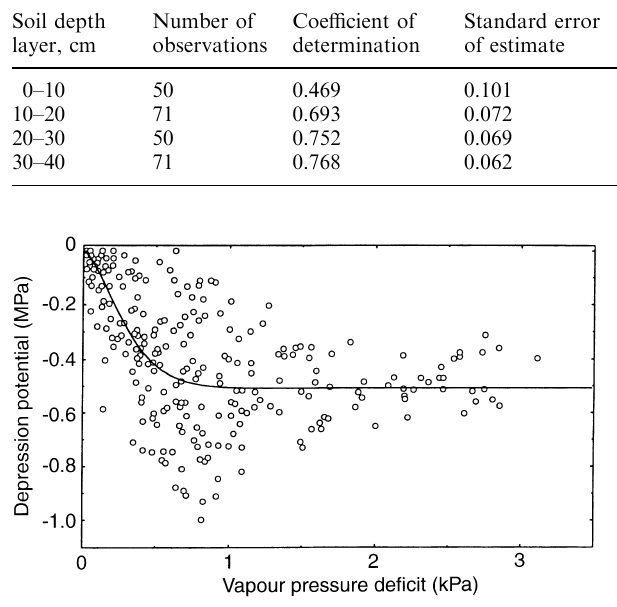
Table 1. Coe(cid:129)cients of determination ( R 2 ) and standard errors of estimate ( SEE ) for the regressions of base water potential from available soil water storage (cid:133) (cid:87) b (cid:136) a (cid:135) b = (cid:133) W c